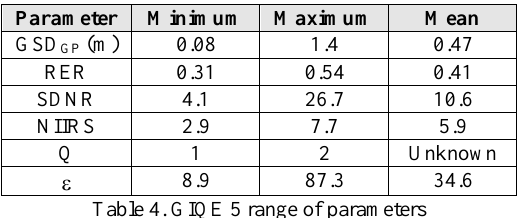
Table 4. GIQE 5 range of